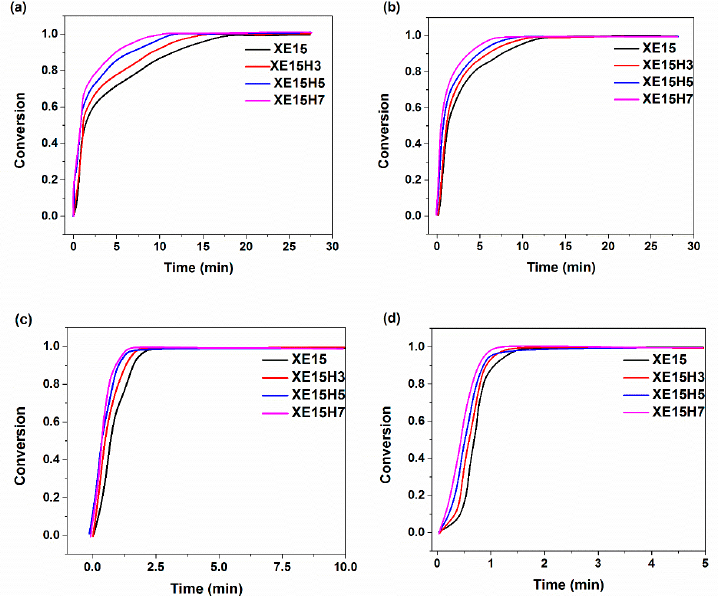
Figure 2. Variation the degree of cure parameter with respect to the time for various XNBR/epoxy/XHNTs at different heating temperatures ( a ) 170 °C ( b ) 180 °C ( c ) 190 °C ( d ) 200 °C calculated by using Equation (2).